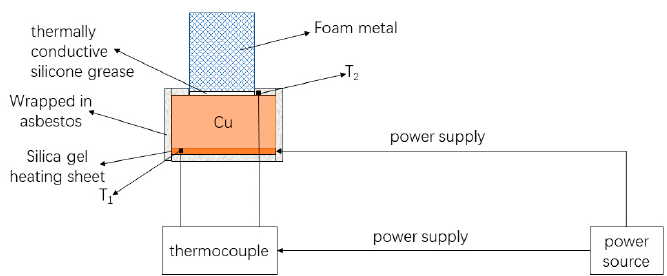
Figure 6. Natural convection cooling test setup.